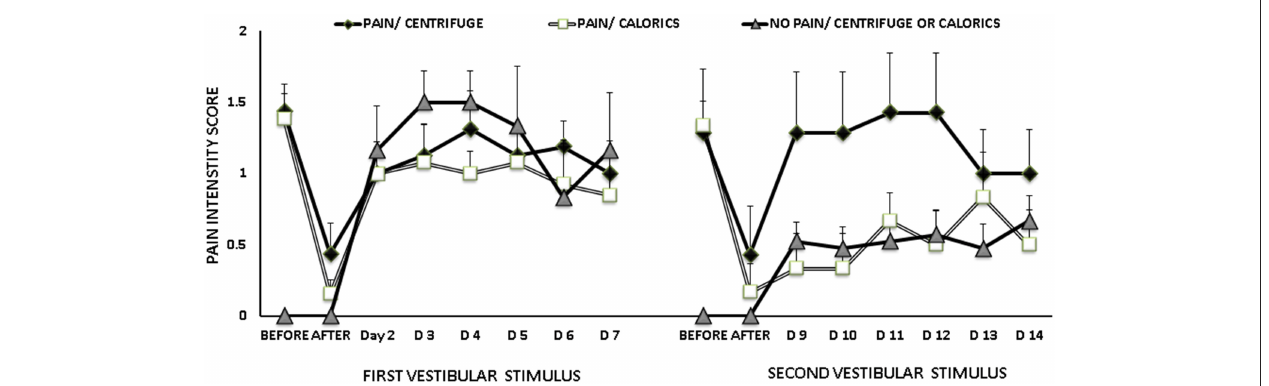
FIGURE 1 | Mean and standard error of the mean of pain intensity scores, before and after vestibular stimulation, according to the report of phantom limb pain at the moment of vestibular stimulation and the type of stimuli, either caloric stimulation or unilateral centrifugation. At the second stimulation, patients who already received caloric stimulation were assigned to unilateral centrifugation and visceversa . At the first vestibular stimulation, among 28 patients with phantom pain 13 received caloric stimulation and 15 received unilateral centrifugation, while 6 patients reported no phantom pain. At the second vestibular stimulation, among 11 patients with phantom pain 5 received caloric stimulation and 6 received unilateral centrifugation, while 20 patients reported no phantom pain.